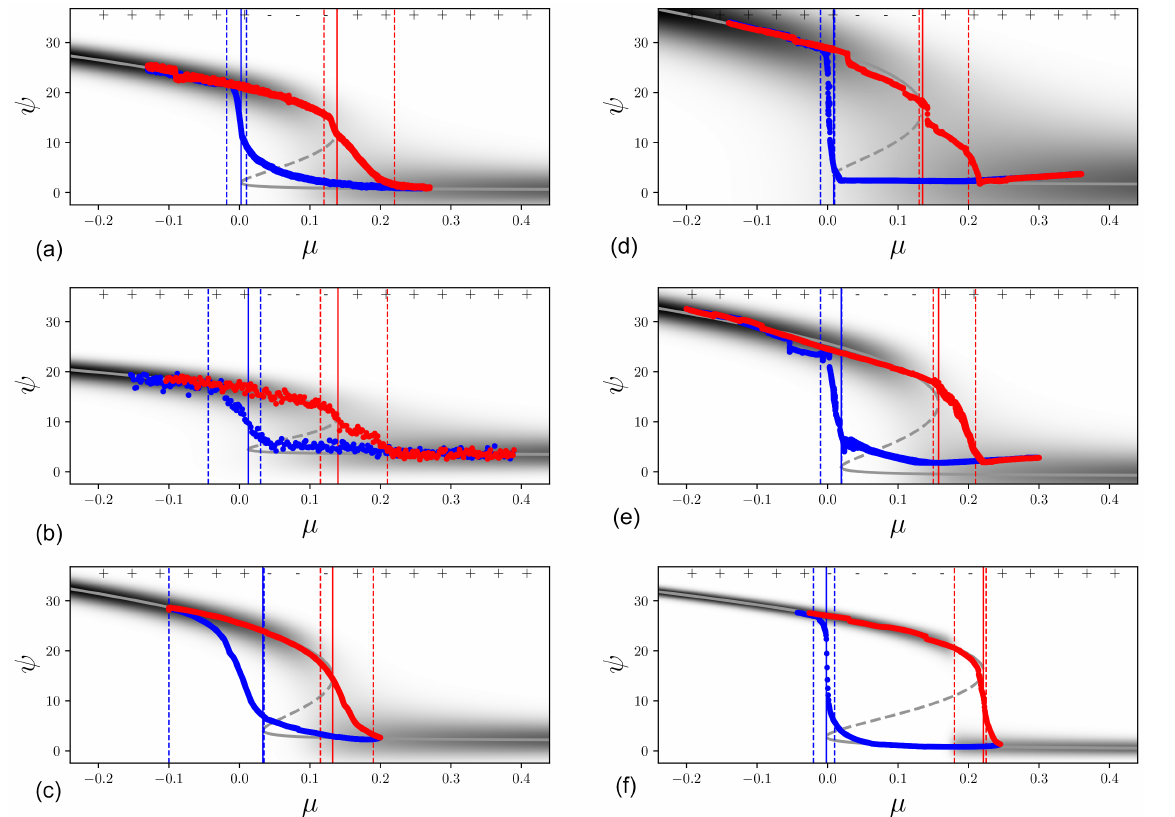
Figure 7. Estimated distributions under changing µ : (a, b, c) Bremen, ECBilt-CLIO, and C-GOLDSTEIN; (d, e, f) MOM hor, MOM iso, and UVic. Vertical dashed lines mark the chosen boundary values for µ ± , with solid lines showing the fit values. The dashed grey line indicates the local minimum in the distribution (trench). The top ± symbols indicate the sign of the discriminant D for the fitted distribution ( + for unimodal, − for bimodal). Distribution spreads have been inflated with a factor ν/ 2 to make them visible. All values have are given in units of Sv. Table 3. Mean values and standard deviations of parameters corresponding to the fitted functions in Fig. 7. The root-mean-square deviation (a goodness of fit measure) has been determined on the upper branch up to the fitted collapse point. ν λ β 0 δβ µ − [Sv] µ + [Sv] rms deviation